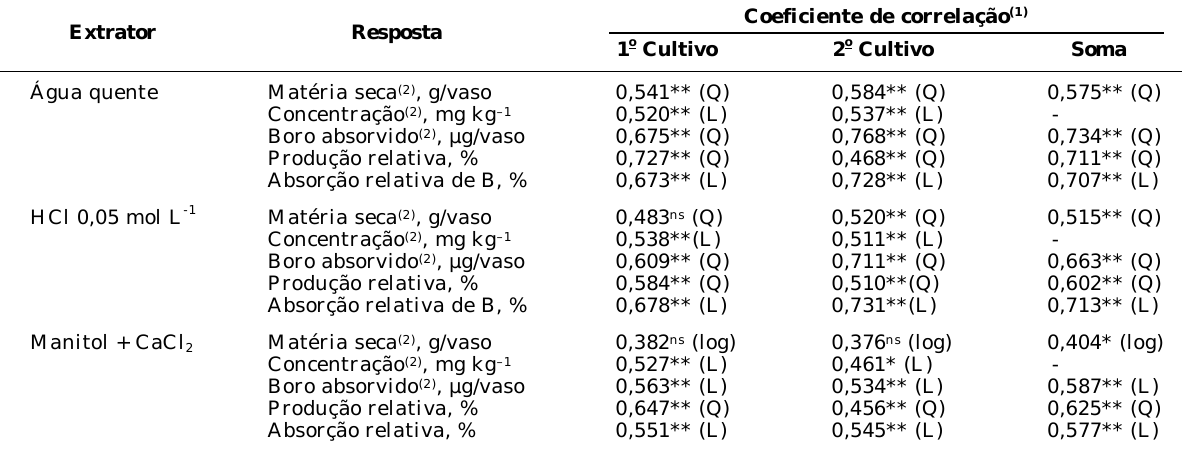
(1) Coeficientes seguidos de ns = não-significativo, de * e ** = significativos a 5 e 1% respectivamente; segundo os modelos: linear (L), quadrático (Q) e logarítmico (log), que melhor explicaram a relação entre as variáveis. (2) Característica avaliada no tratamento sem boro.